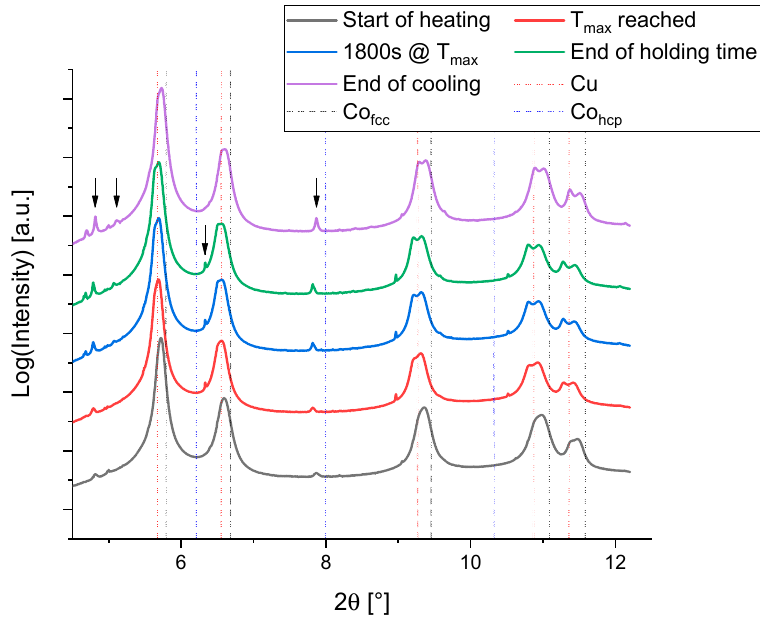
Figure 2. Five high-energy X-ray diffraction (HEXRD) patterns taken out of the sequence of more than 1200 patterns, recorded during the in-situ annealing treatment of Cu 55 Co 45 at 490 °C. The time frame shown above covers the complete experiment. Gradual peak splitting and double peak formation, can easiest be seen for high diffraction angles. However, the apparent peak shift for patterns taken at elevated temperatures is mainly due to thermal expansion. Note, not all hcp-Co lines (data taken from [33]) are shown, but those where the absence of hcp-Co becomes evident. Small peaks at diffraction angles of ~5° and ~8° can be explained by oxides such as CoO, CuCoO, or Cu 2 O. Those that are clearly identified are marked with arrows in the uppermost patterns.